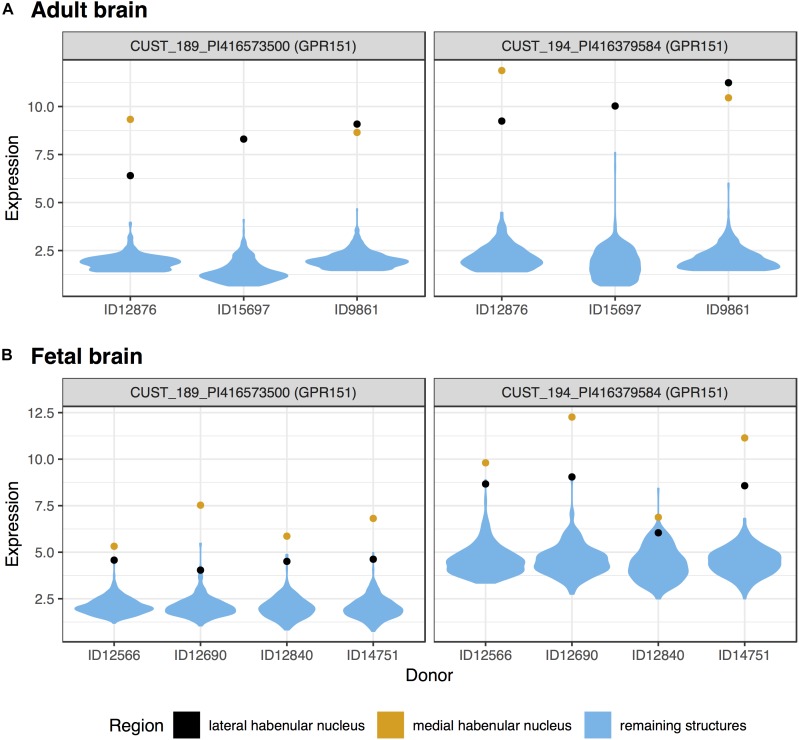
Violin plots of GPR151 expression in the adult (A) and fetal (B) brains. Expression (log2 intensity) is plotted on the y-axis for each of the two probes for GPR151. Donor identification numbers are marked in the x-axis. Expression in the lateral habenula is marked in black with orange marking the medial division. The distribution of expression across the remaining sampled regions is shown in blue.